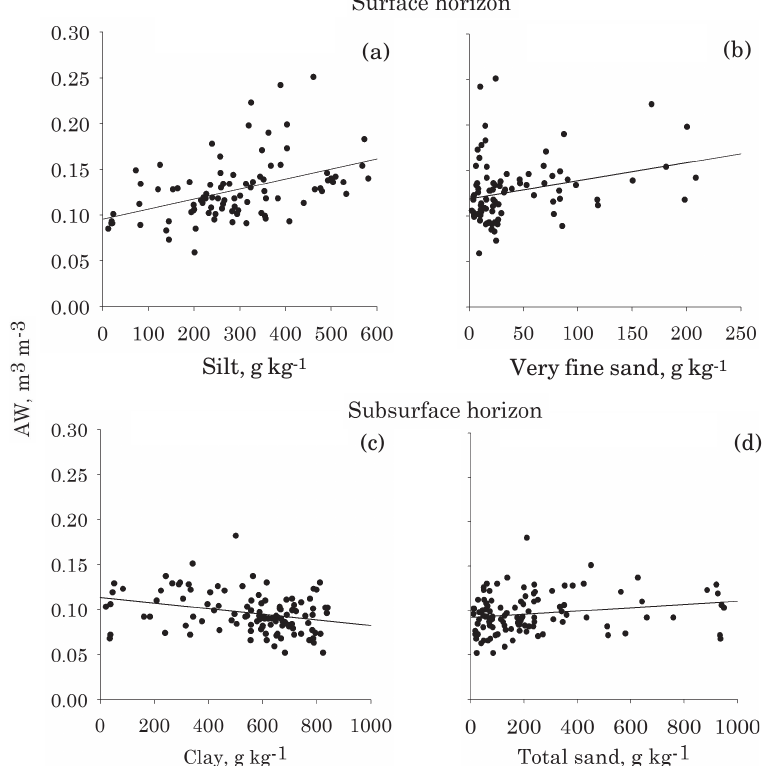
Figure 2. Scatter plots between the available water content (AW) and the contents of silt and very fine sand in the surface horizons (a, b), and between AW and the clay and total sand contents in the subsurface horizons (c, d) in soils of theSstate of Santa